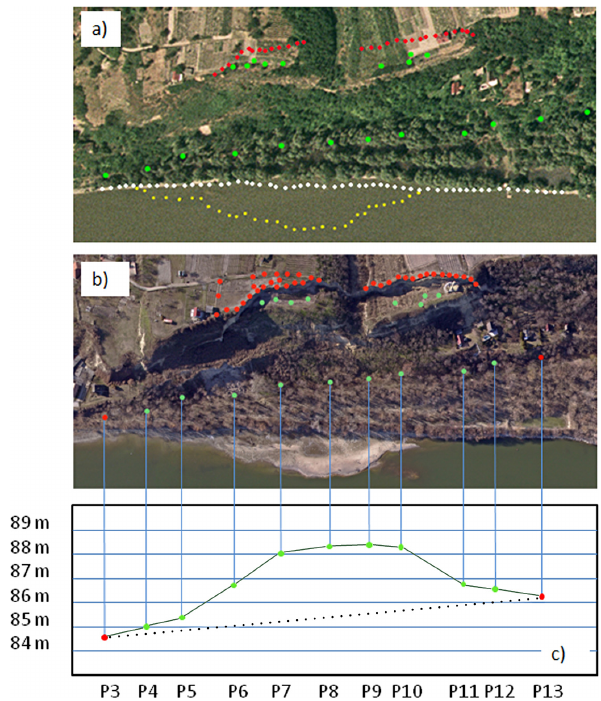
Fig. 2. The landslide on the right river bank of the Danube river, near Dunaszekcs¨o; red dots are geodetic measuring points outside the slide, green dots are geodetic measuring points on the slide; (a) Orthophoto of the initial state before the slide; yellow dots mark the extent of the bulge in the Danube river generated by the mass movement; (b) on oblique aerial photo of the situation after the slide; (c) elevations along a geodetic profile at the originally flat river